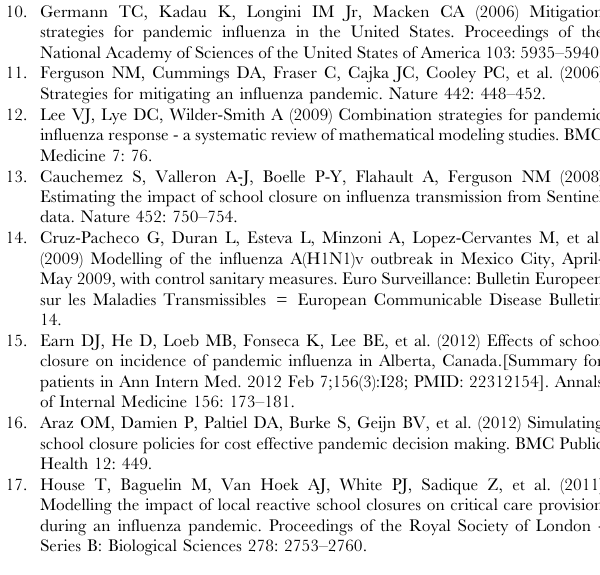
Figure S1: Identification of mathematical modelling studies of the effects of school closure on influenza outbreak. Figure S2: Further estimates of the influence of the duration of school closure on the predicted effects of pandemic influenza. Table S1: Features of modelling studies identified. Table S2: Mathematical modelling studies of the effects of school closure on pandemic